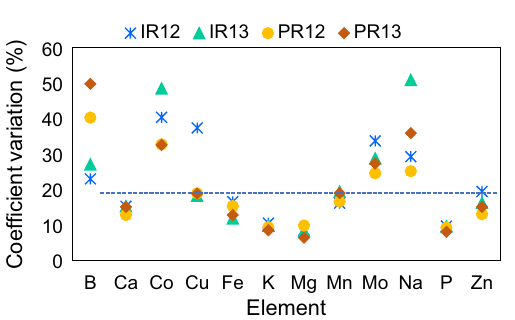
Figure 2. The coefficient of variation (%) of 12 elements in the grain the rice panel grown at four environments (IR12: IRRI 2012, IR13: IRRI 2013, PR12: PhilRice 2012, PR13: PhilRice